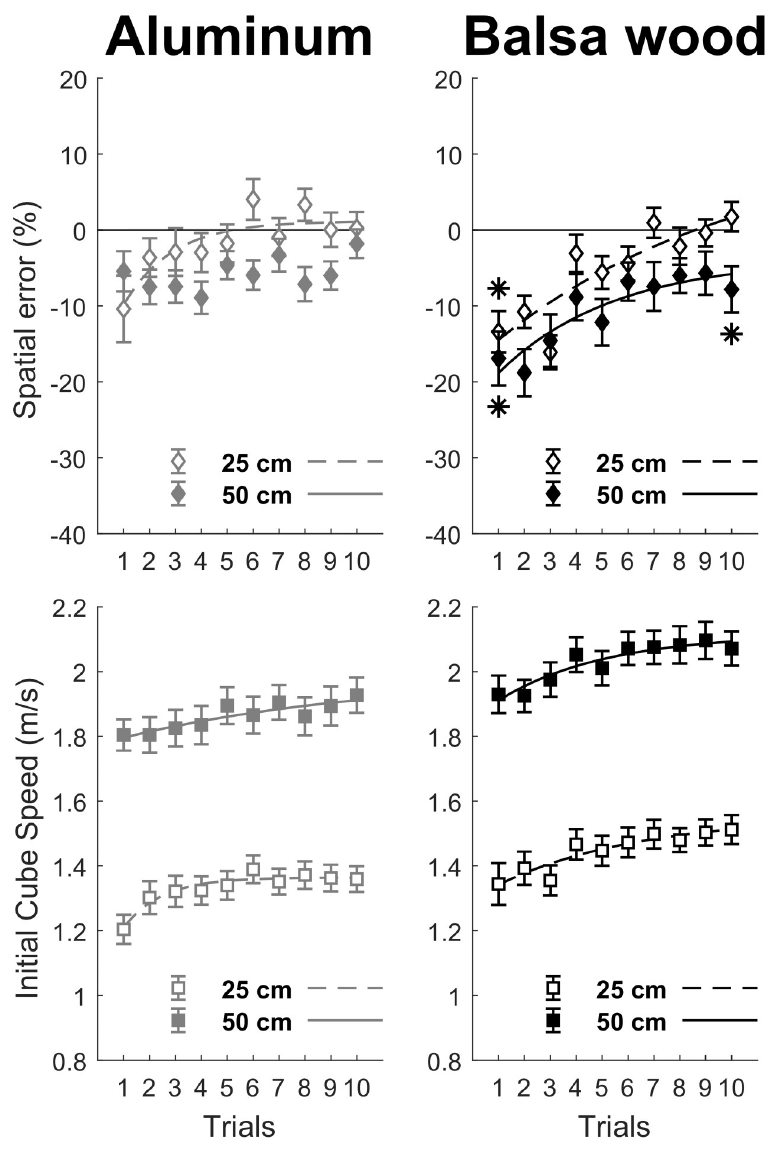
Fig 4. Performance and motor adaptation as a function of surface material and target distance. Motor adaptation across trials is observed mainly for the balsa wood surface material (right panels) corresponding to more demanding conditions in order to counteract the effect of friction on cube displacement. Exponential fits with R 2 > 0.75 are illustrated, together with asterisks when initial and final mean spatial error differed significantly (Bonferroni correction with α = 0.05/4 = 0.008 for each surface material) from